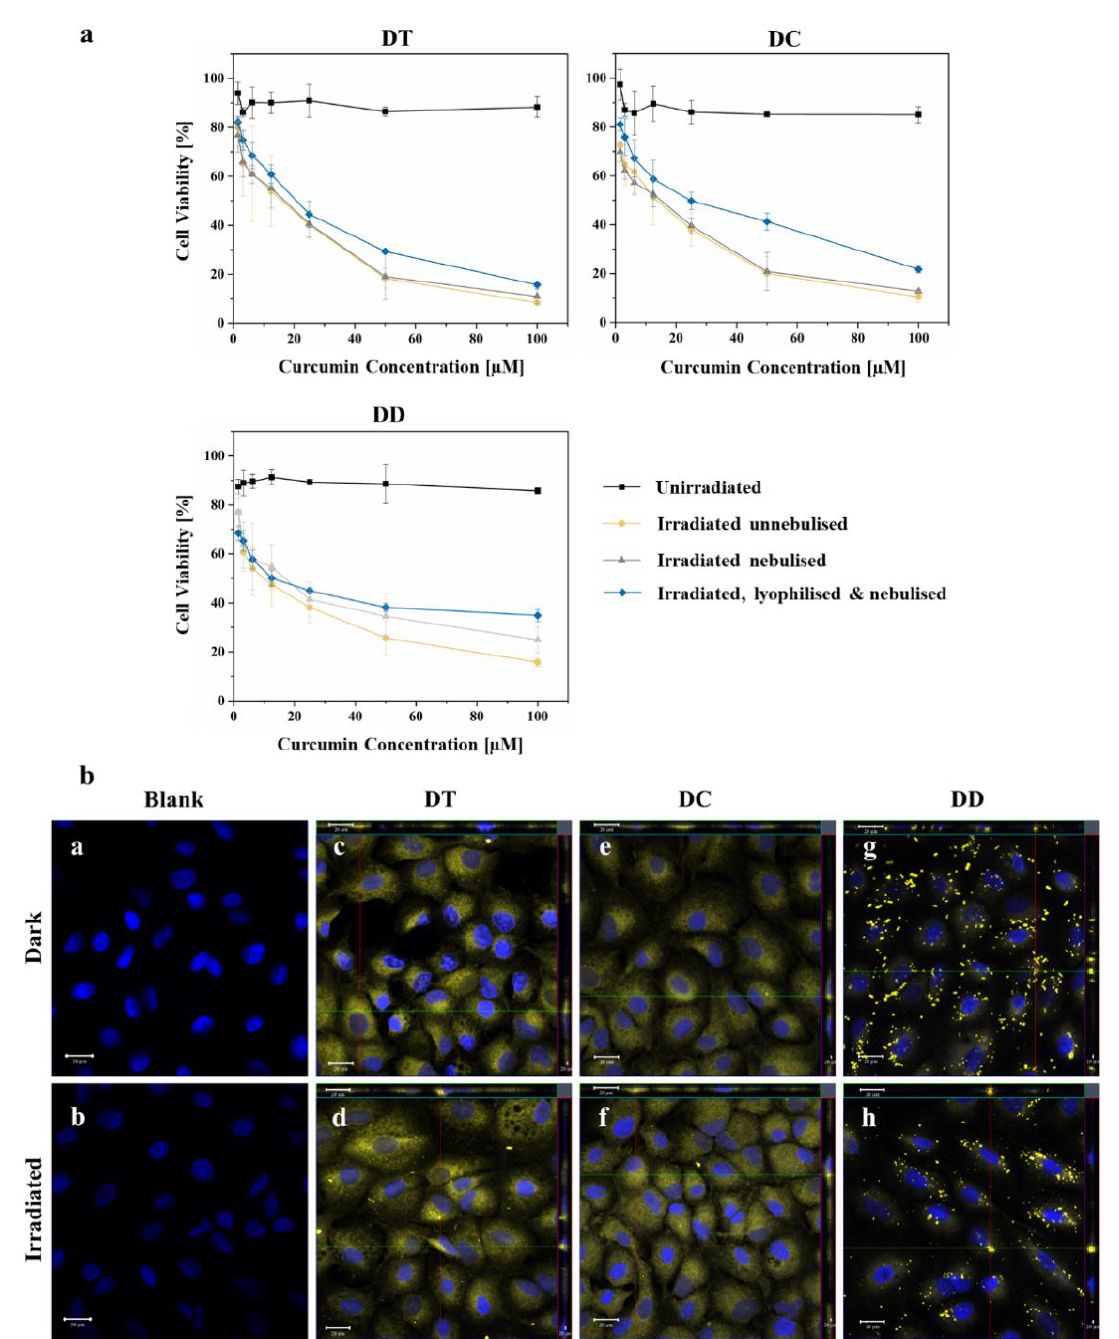
Figure 6. ( a ) MTT in vitro cytotoxicity assay of DT, DC and DD containing a curcumin concentration up to 100 µM. The figure shows a comparison of dark control, irradiated (IR) unnebulised, IR nebulised (PARI VELOX ® ) and IR lyophilised & nebulised curcumin-loaded liposomes. Irradiation always took place at 457 nm with a fluence of 6.61 J cm −2 ; ( b ) CLSM micrographs of A549 cells with nebulised curcumin-loaded liposomes containing a curcumin concentration of 100 µM. Dark and irradiated (457 nm, 6.61 J cm −2 ) samples were compared for the formulations: DT, ( c , d ); DC, ( e , f ); and DD, ( g , h ). Untreated cells were used for the blank micrographs ( a , b ). The cell nuclei were counterstained with 0.1 µg/mL DAPI and fixed with a 4% formaldehyde solution for all micrographs. Scale bars represent 20 µM.